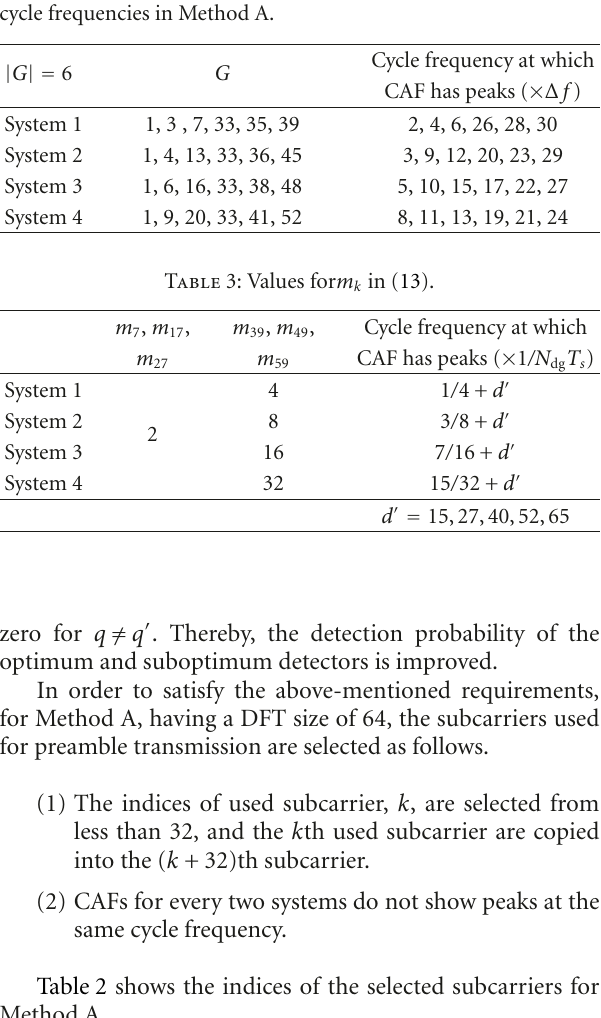
Table 2: Indices of selected subcarriers and their corresponding cycle frequencies in Method A.